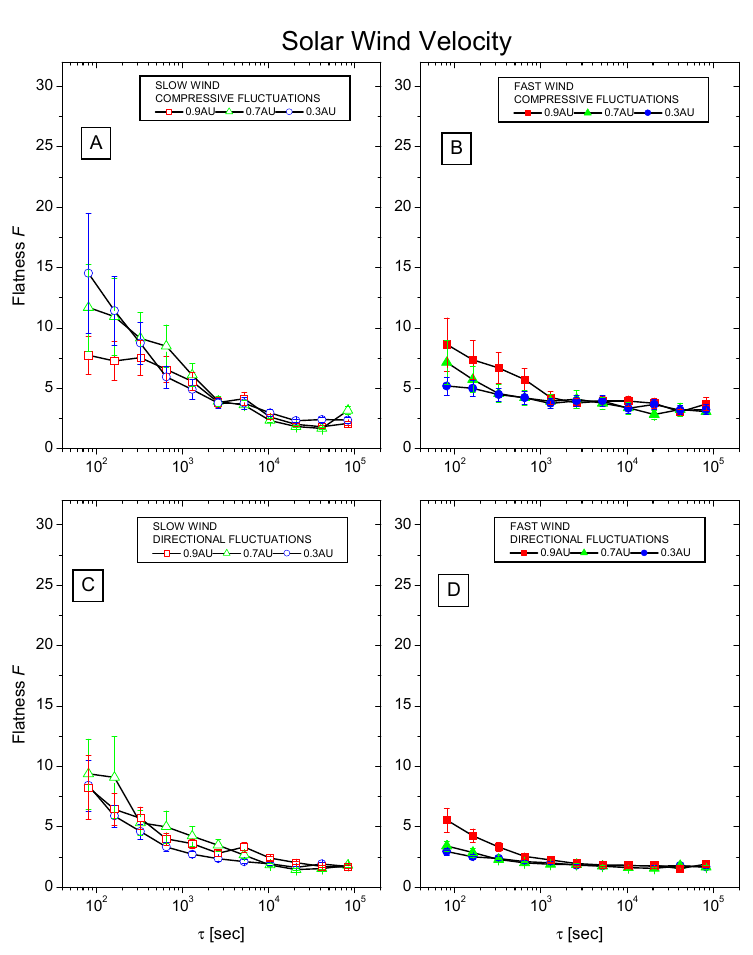
Figure 107: Flatness ℱ vs. time scale 𝜏 relative to wind velocity fluctuations. In the same format of Figure 106 panels A and C refer to slow wind and panels B and D refer to fast wind. The upper panels refer to compressive fluctuations and the lower panels refer to directional fluctuations. Vertical bars represent errors associated with each value of ℱ . Image reproduced by permission from Bruno et al. (2003b), copyright by